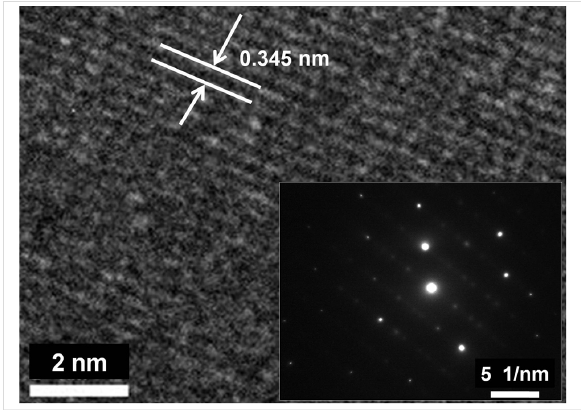
Figure 6: HRTEM image of an as-synthesized h-MoO 3 nanorod and their electron diffraction pattern (inset).